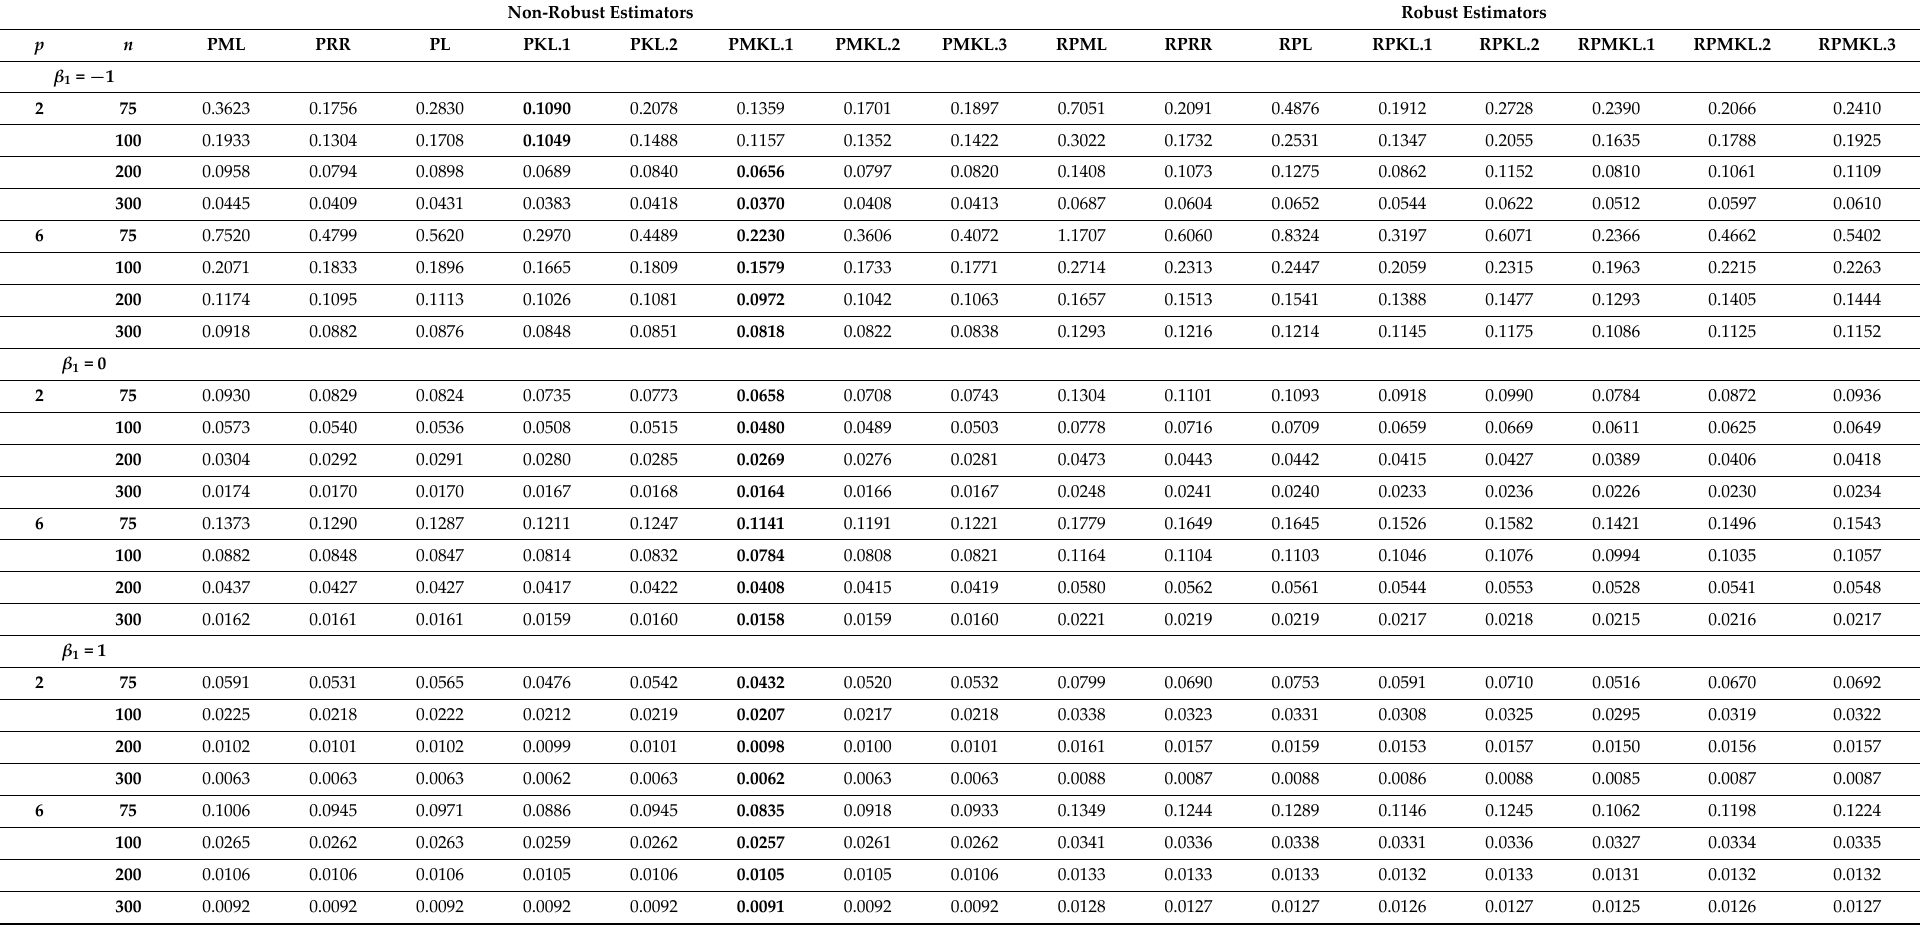
Table A1. AMSE of different estimators when τ = 0% and ρ =